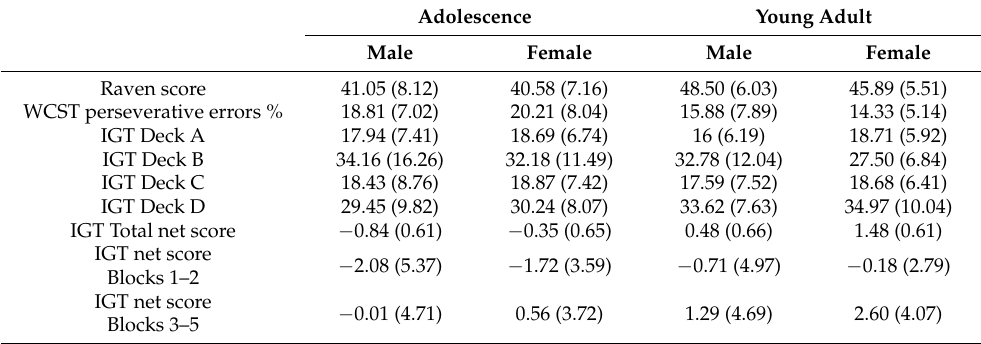
Table 1. Performance means (and standard deviations) for cognitive tasks by age group and